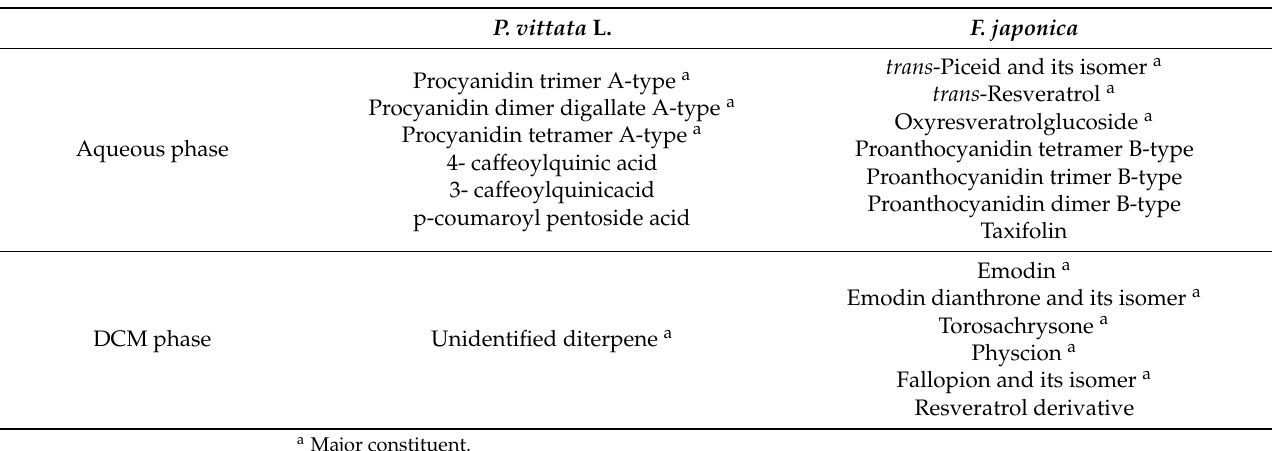
Table 1. Chemical composition of aqueous and dichloromethane (DCM) phases of Pteris vittata L. and Fallopia japonica